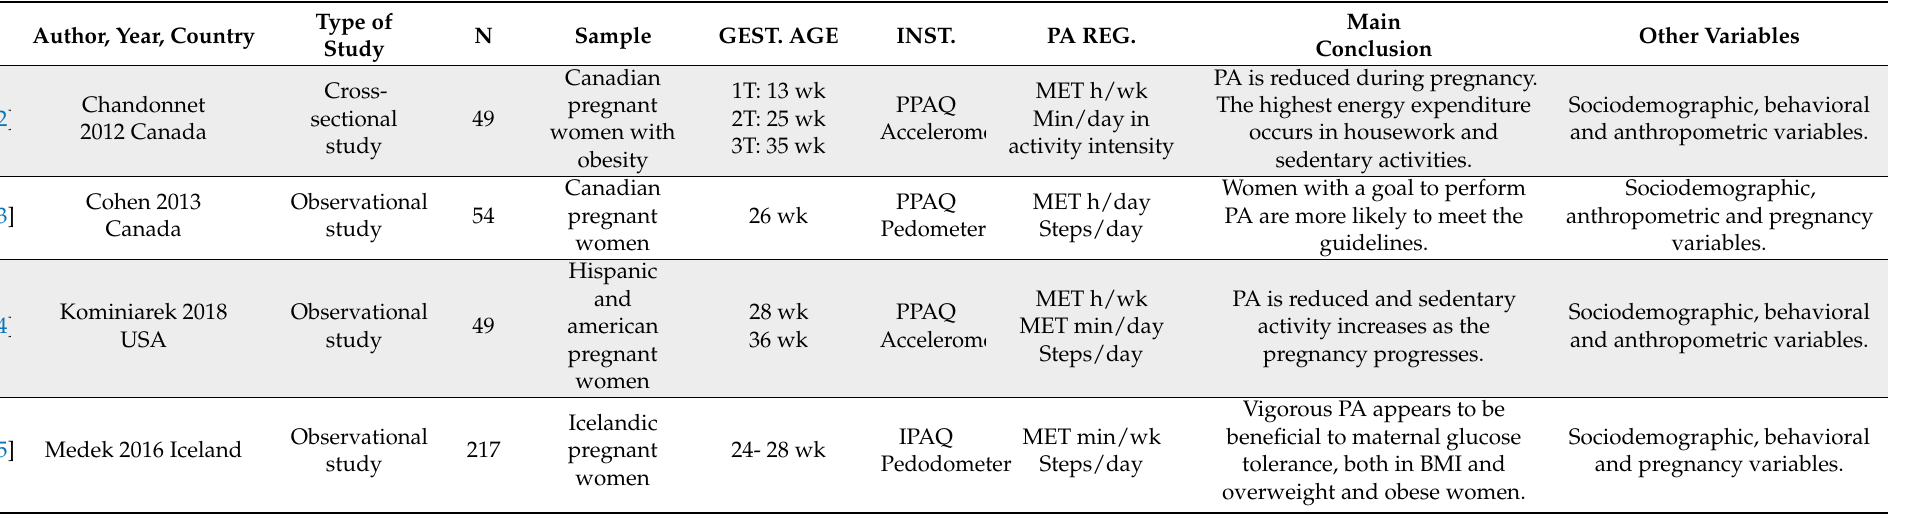
Table 7. Direct and indirect measurements with mixed studies of physical activity during